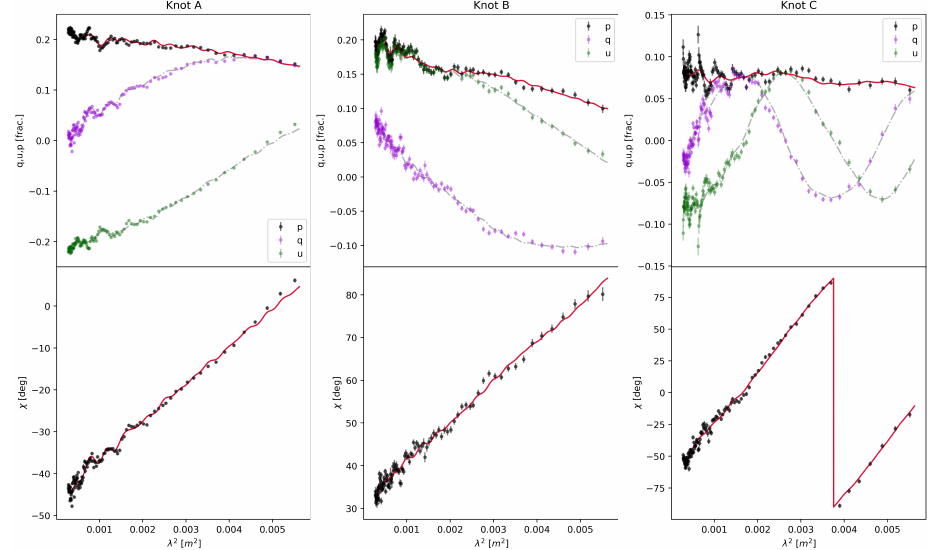
Figure 5. RM map of the kpc jet of M87. Color scale: from values are detected.